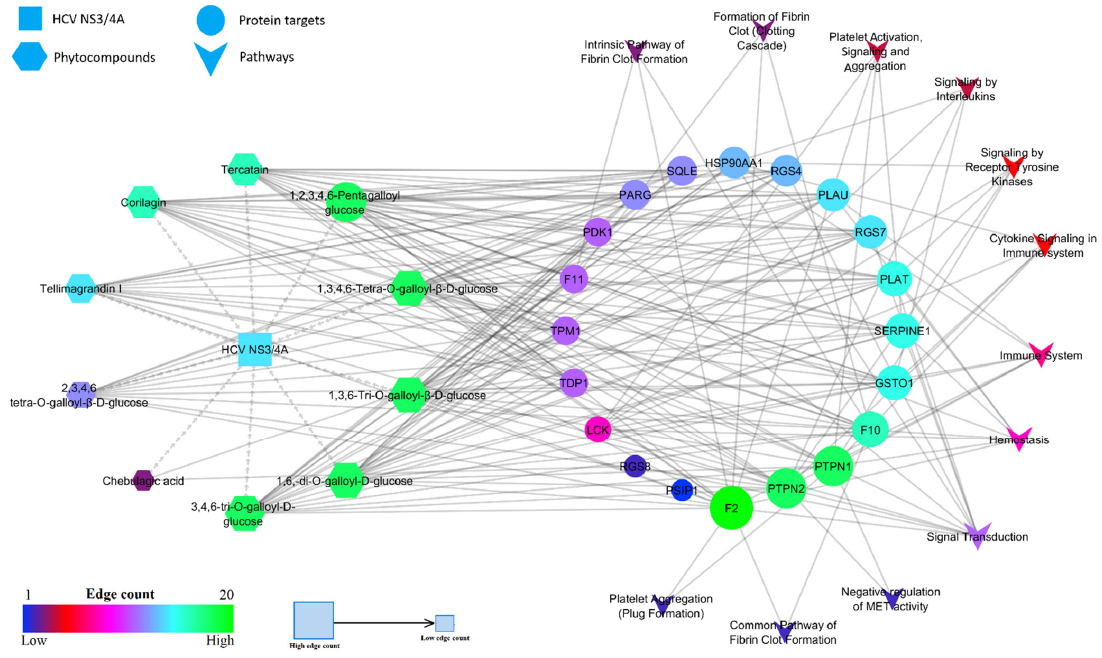
Figure 3. Network representation of phytocompound-target-pathway.